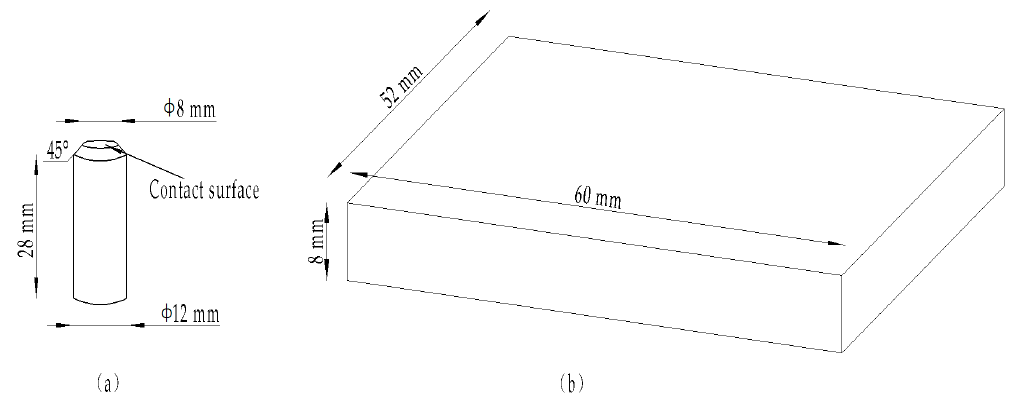
Figure 1. Experiment samples for ( a ) pin of aluminum alloy 6016 and ( b ) plate of CoCrMo. As non-contact measurement does not damage the surface to be tested, this experiment used a non-contact measurement method to measure the aluminum alloy 6016 surfaces. The 3D profilometer used in the experiment was the VR series 3D profilometer VR-5000 produced by Keyence (Osaka, Japan). The measuring range was 206 mm × 104 mm, the measuring accuracy was 0.5 μ m, and the imaging component was a 1 inch and 4-megapixel monochrome Complementary Metal Oxide Semiconductor (CMOS) camera (1 inch and 4 million pixels, Keyence, Osaka, Japan), as is shown in